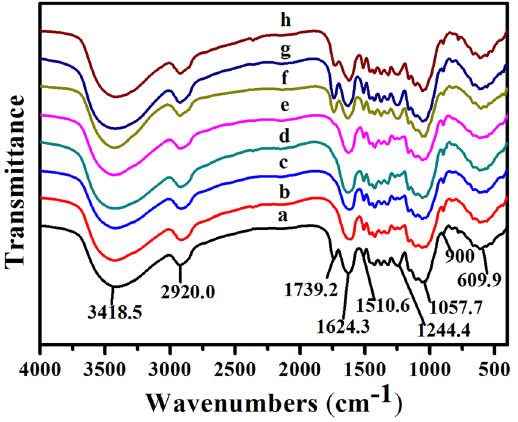
Figure 4. FTIR spectra, ( a ) untreated CS; ( b ) 3% KOH-treated CS; ( c ) 1.5% NaOH-treated CS; ( d ) 1%